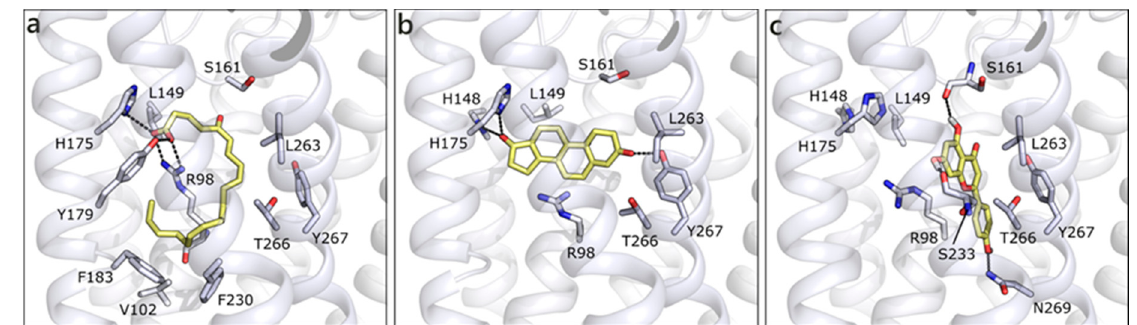
Figure 10. Docking poses of 5-oxo-ETE ( a ), T ( b ), and API ( c ) in OXER1 model. The protein is shown in white cartoon, the residues lining the binding site and the ligands are shown in capped sticks and colored white and yellow, respectively. Helices and residues lining the pocket are labelled, hydrogen bonds are displayed as black dashed lines.